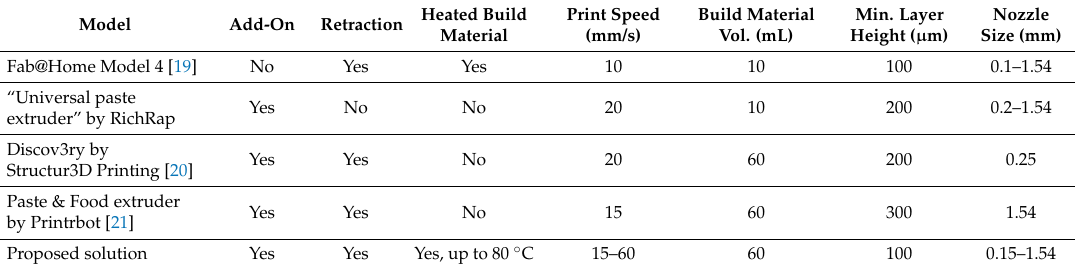
Table 4. Comparison of proposed solution with existing syringe-based paste